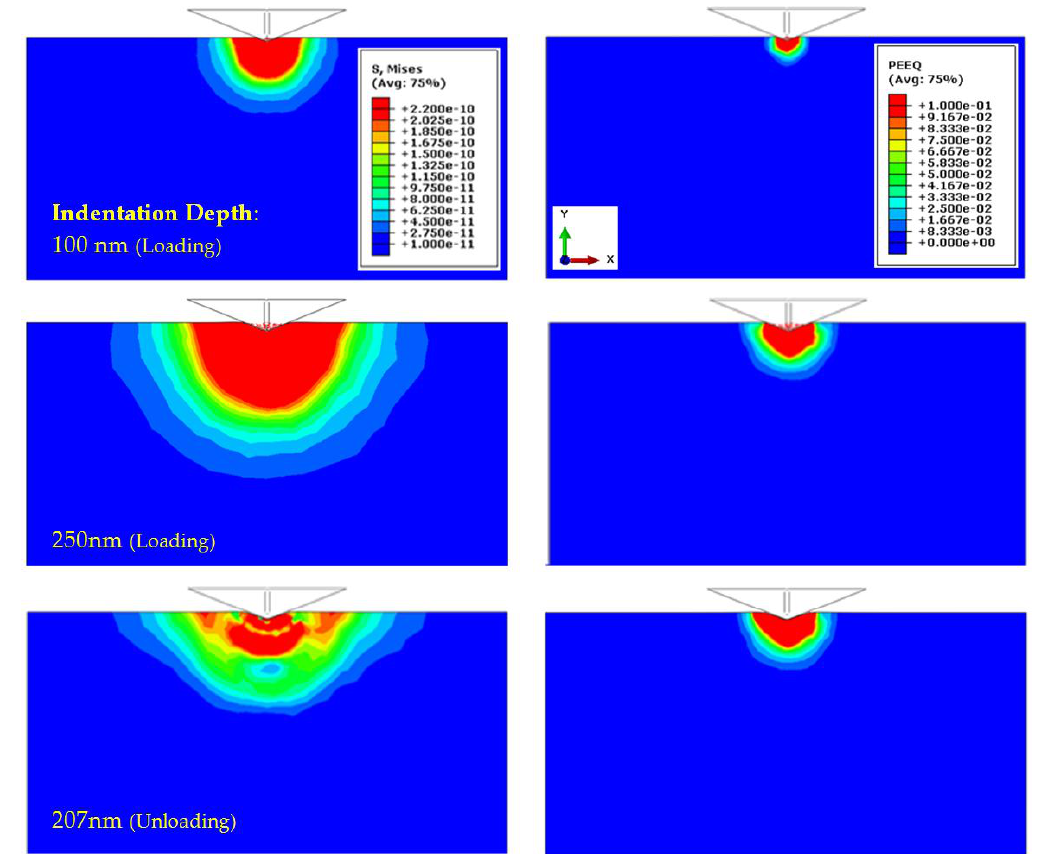
Figure 9. Contour plots of von Mises stress (top), and equivalent plastic strain (bottom) at the center of the x - y plane of the aluminum block in the nanoindentation